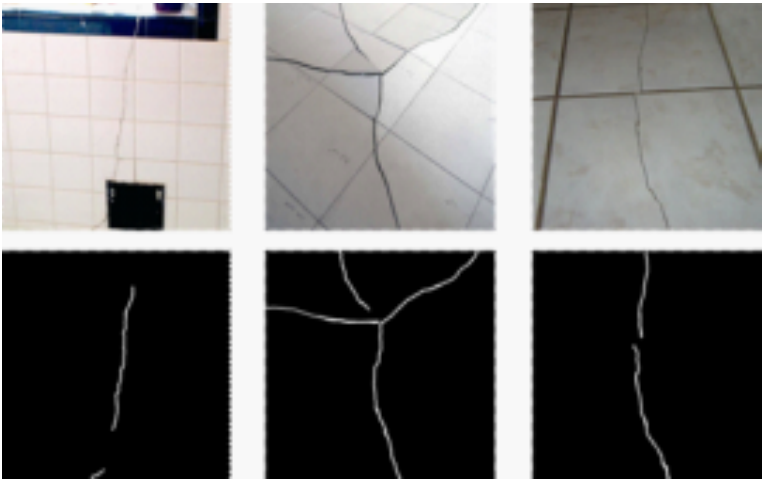
Figure 3. Examples of images collected to assemble the database and their respective ground truth (black and